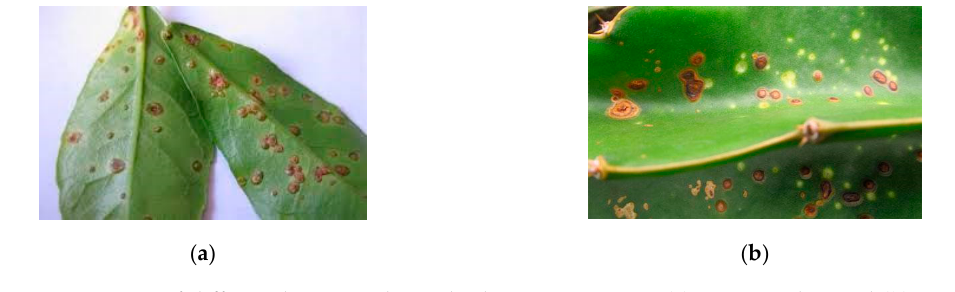
Figure 1. Images of different leaves with similar lesion structures: ( a ) citrus canker and ( b ) pitaya canker. If there is no leaf information, it is difficult to distinguish the type of